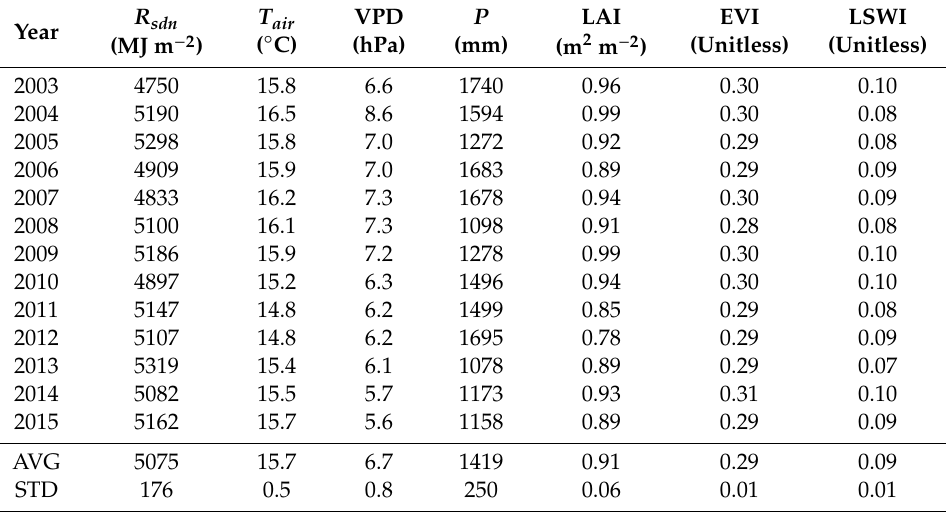
Table 2. Annual values of integrated (or averaged) downward shortwave radiation ( R sdn ), daytime air temperature ( T air ), daytime vapor pressure deficit (VPD), precipitation ( P ), leaf area index (LAI), enhance vegetation index (EVI), and land–surface water index (LSWI) from 2003 to 2015 for the study site. AVG denotes average; STD denotes standard deviation.